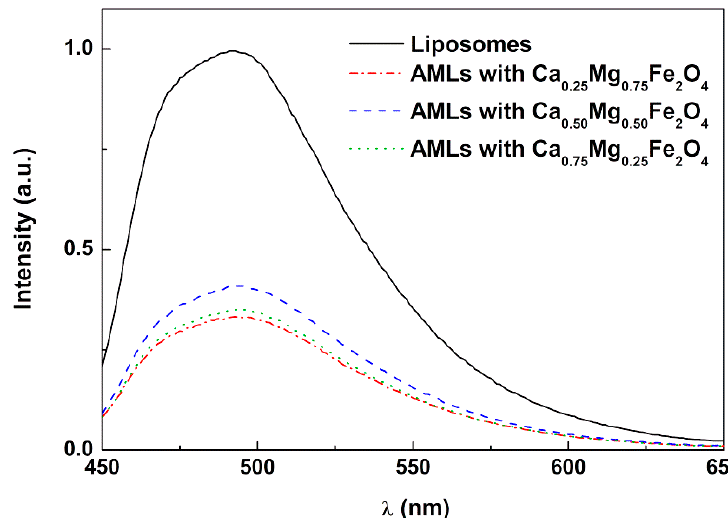
Figure 6. Fluorescence spectra of curcumin encapsulated in liposomes and aqueous magnetoliposomes based on calcium-substituted magnesium ferrite nanoparticles.